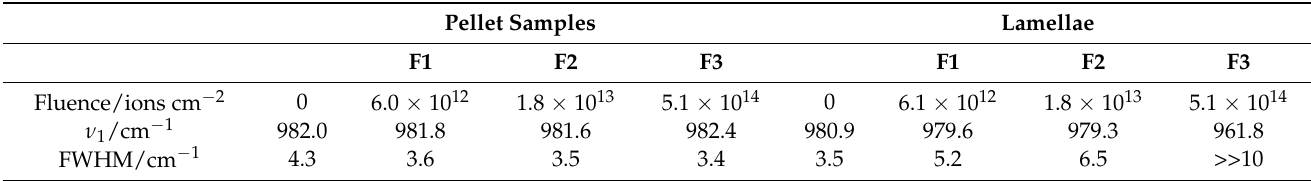
Table 5. Position and FWHM of the Raman band ν 1 of unirradiated and irradiated SmPO 4 pellets and